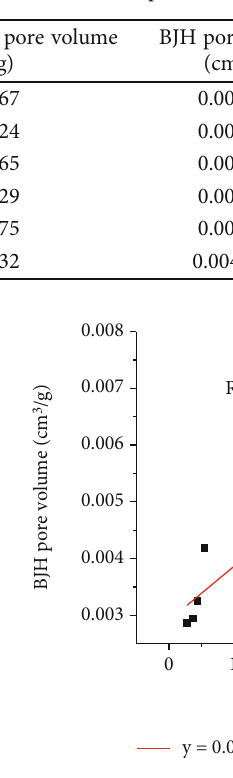
Table 2: Pore structure parameters of coal samples.